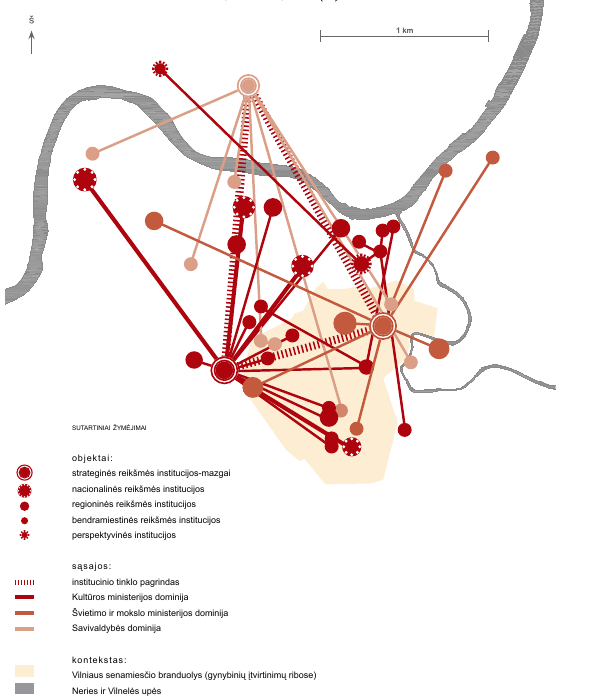
3 pav. Vilniaus miesto centrinės dalies kultūros institucijų tinklas (objektų lygmuo) Fig. 3. Cultural institution network of Vilnius central district (object level)